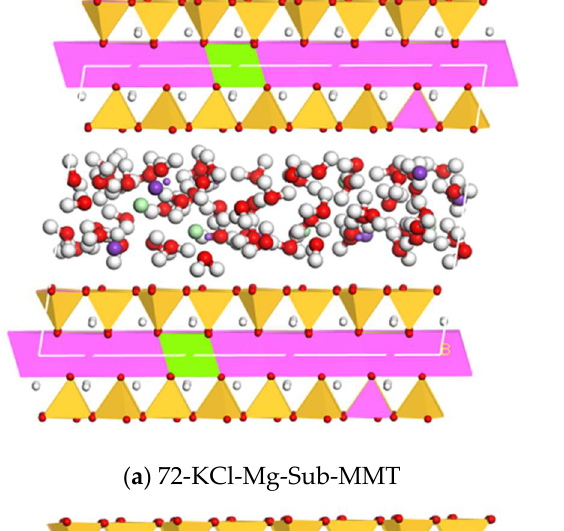
Figure 1. Initial structure of Mg-Sub-MMT with inhibitory cations as counterions. The water molecules in the interlayer are not shown in the right images of different models. The color coding for the atoms is H, white; O, red; Mg, green; Al, pink; Si, gold; K, violet; N, blue; Cs, deep purple; Ca, yellow-green.